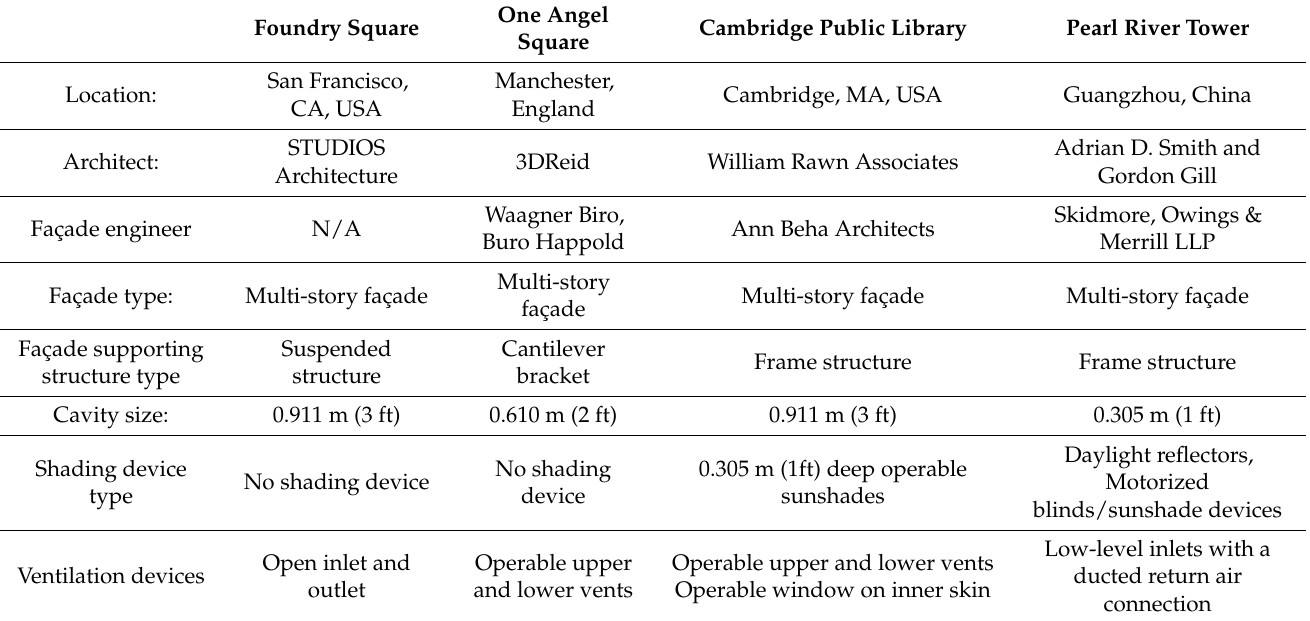
Table 17. DSF Case Study Projects with Overview